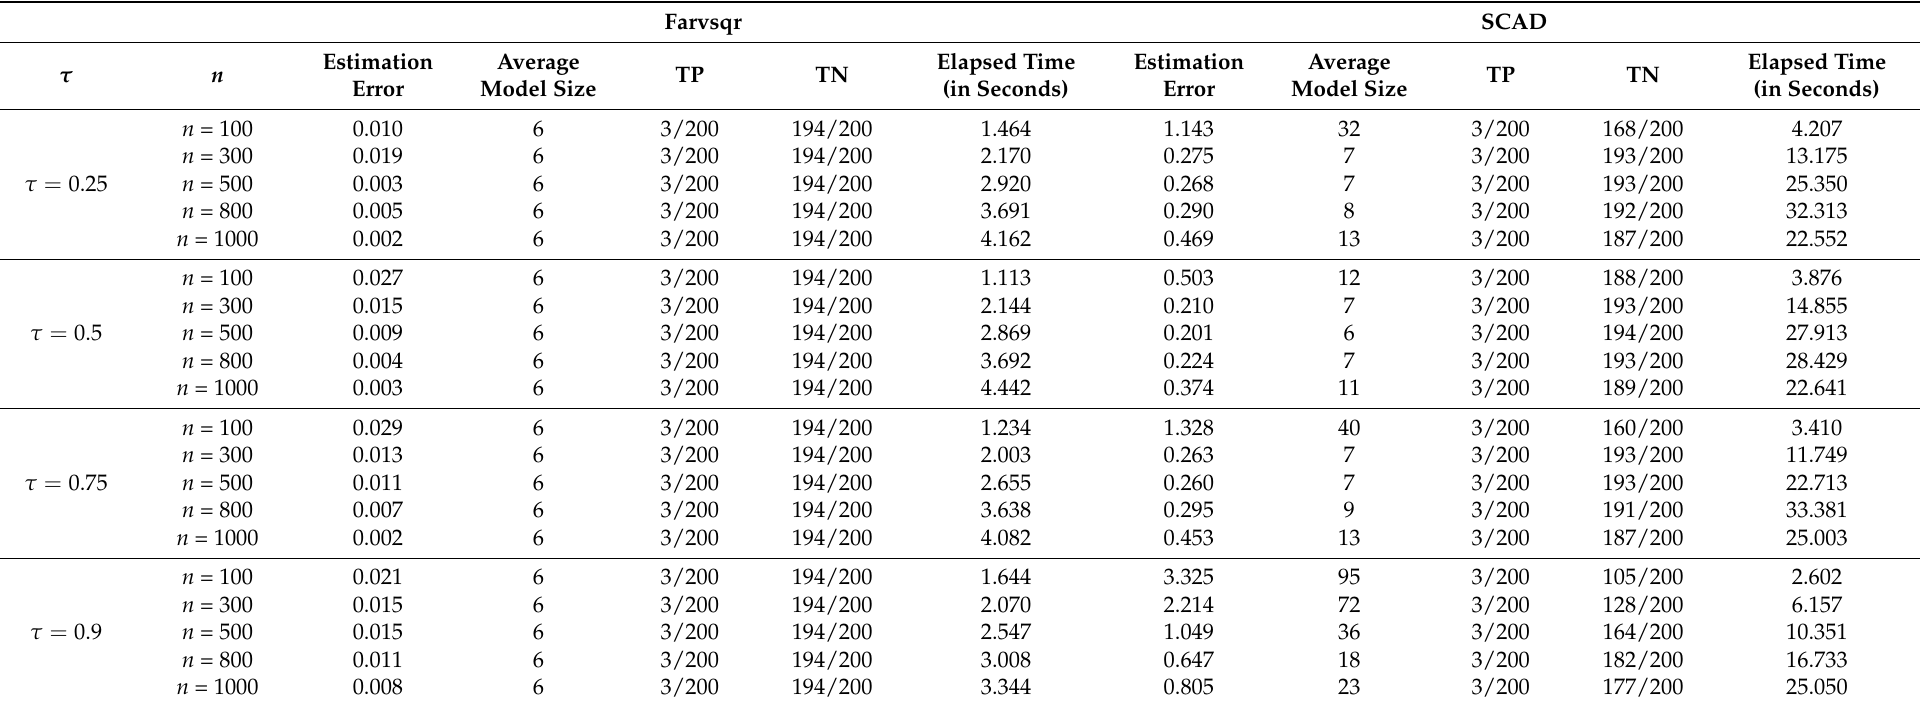
Table 13. The comparison for p = 200, N ( 0,1 ) with the factor model between Farvsqr and SCAD. Farvsqr